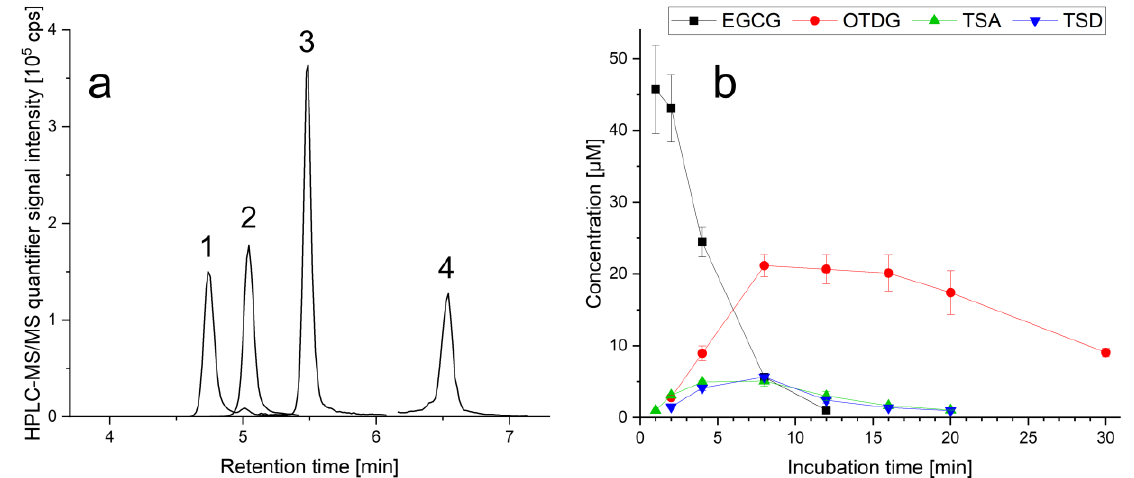
Figure 2. ( a ) Reconstructed HPLC-MS/MS chromatogram after method optimization, each as quan- tifier transition, labeled signals: 1: theasinensin A (TSA, 4 µg/mL), 2: epigallocatechin gallate (EGCG, 30 ng/mL), 3: theasinensin D (TSD, 4 µg/mL), 4: oolongtheanin digallate (OTDG, 4 µg/mL); ( b ) for- mation kinetics of the oxidation products OTDG, TSA and TSD after dilution of EGCG (50 µM) into single supplement-free DMEM cell culture medium at 37 °C, quantified via HPLC-MS/MS, n = 3.